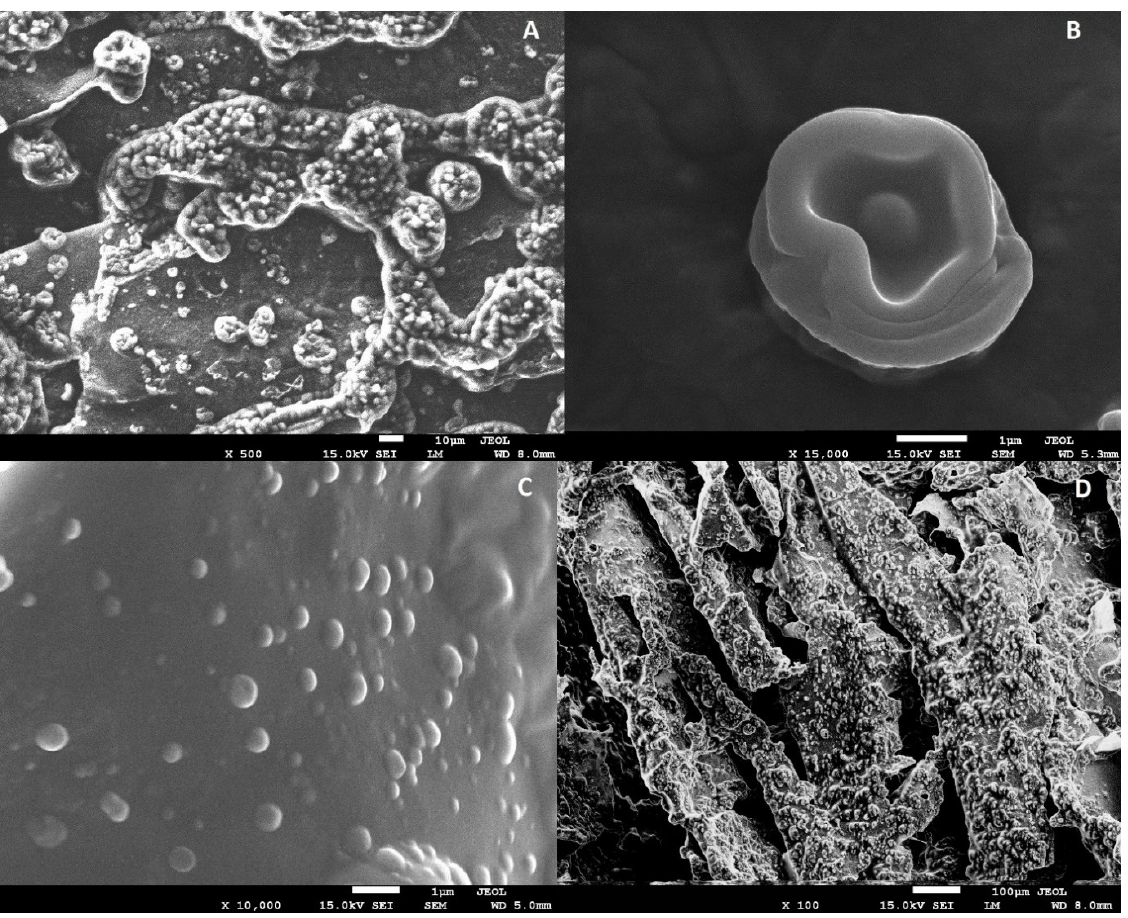
Figure 2. SEM analysis of hydrogels with encapsulated oil: ( A , B ) Concentration of 29%; ( C , D ) concentration in the range of 45%. Table 3. Characteristics of açai extract and safflower